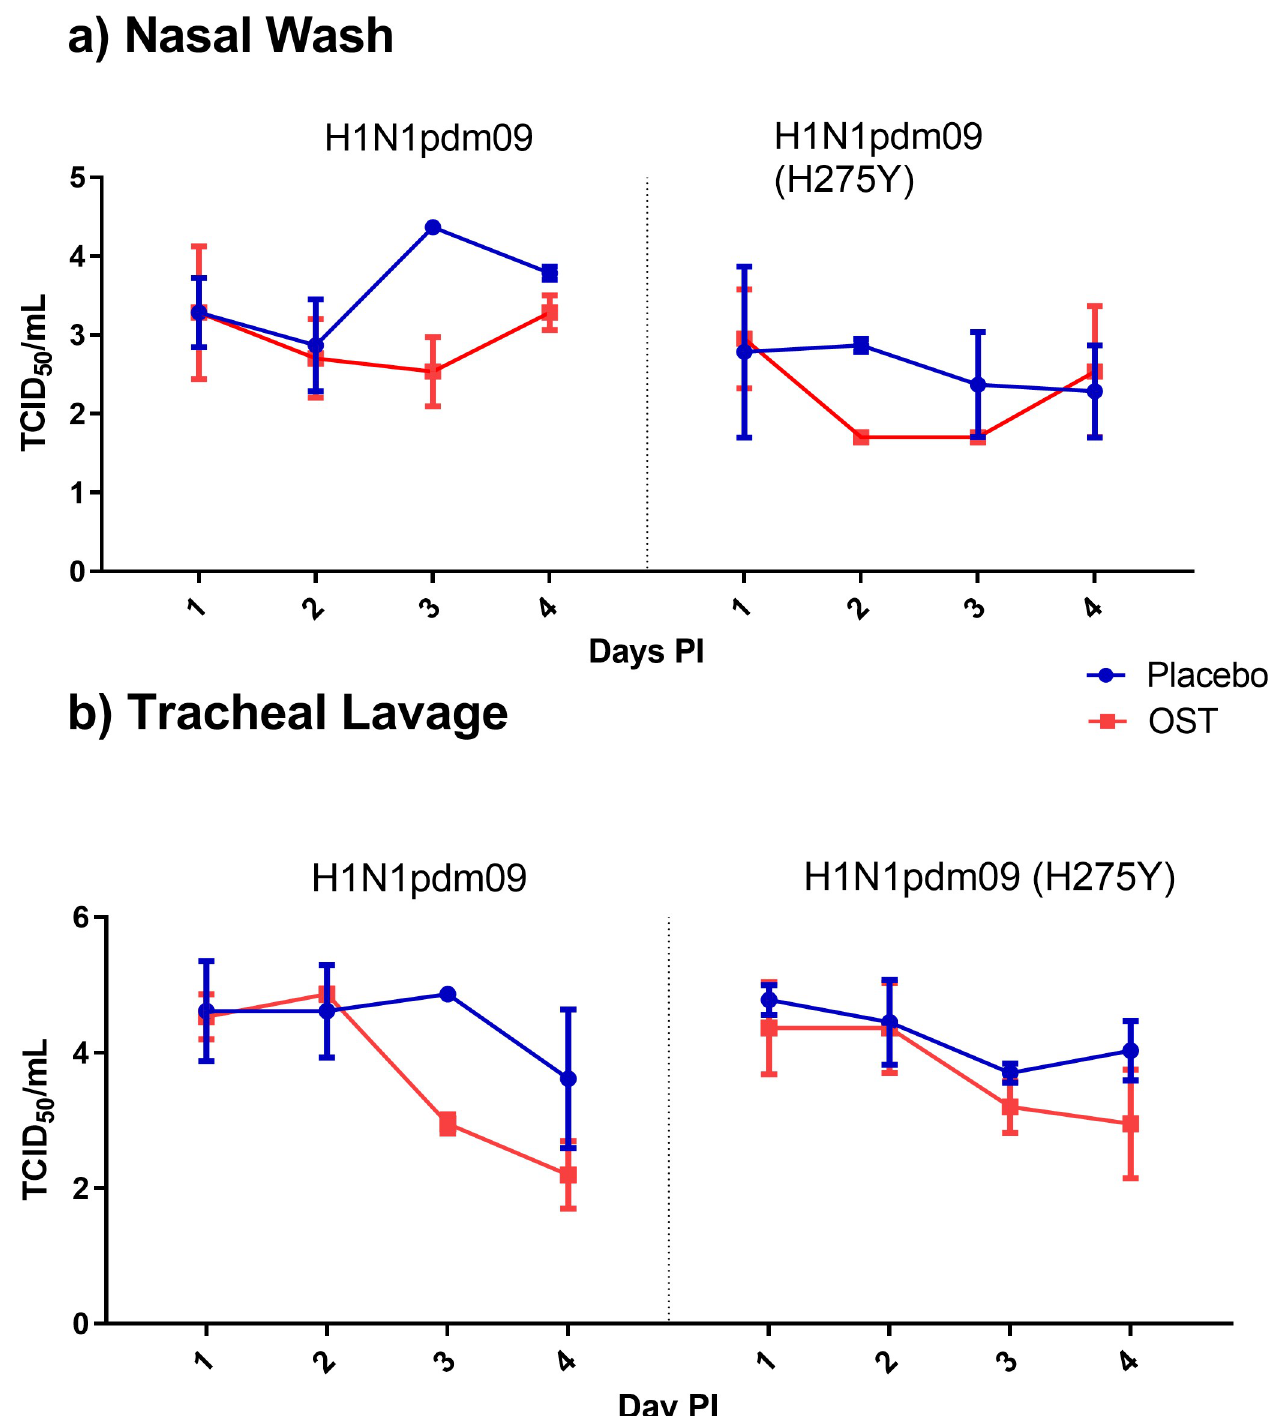
Fig 3. Influenza virus titres from nasal washes and tracheal lavages from macaques infected with either H1N1pdm09 or H1N1pdm09 (H275Y) virus and treated with either OST or placebo. Three macaques were allocated per group and artificially infected with 106 TICD 50 /ml of viral inoculum. No significant differences were observed in viral titre between animals treated with OST compared to those treated with placebo. Panel a) shows viral titre data from nasal washes of animals and b) shows viral tire data from tracheal lavages.